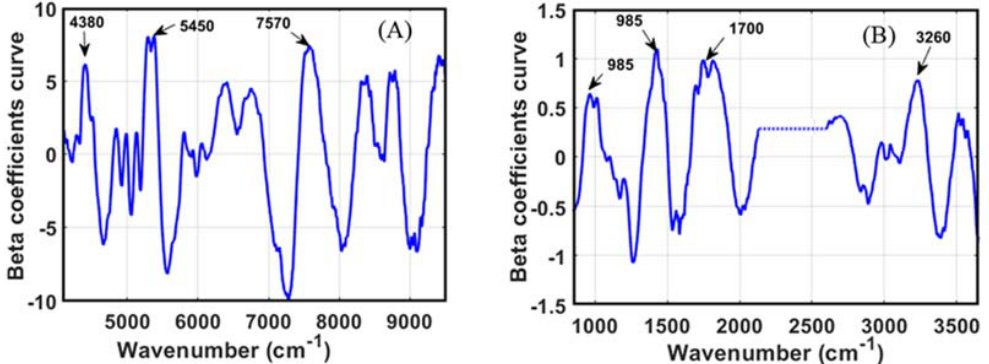
Figure 5. The beta coefficients curve for oligosaccharides prediction in soybean: ( A ) FT-NIR, ( B ) FT- IR.